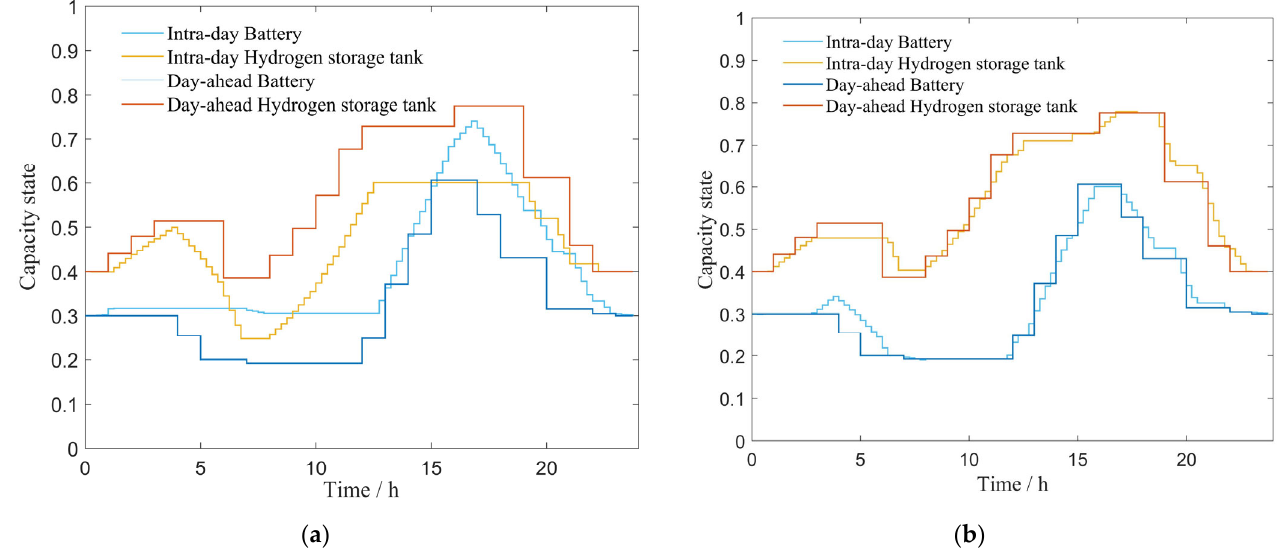
Figure 10. ( a ) Without rolling optimization scenario system capacity status; ( b ) With rolling optimization scenario system capacity status.